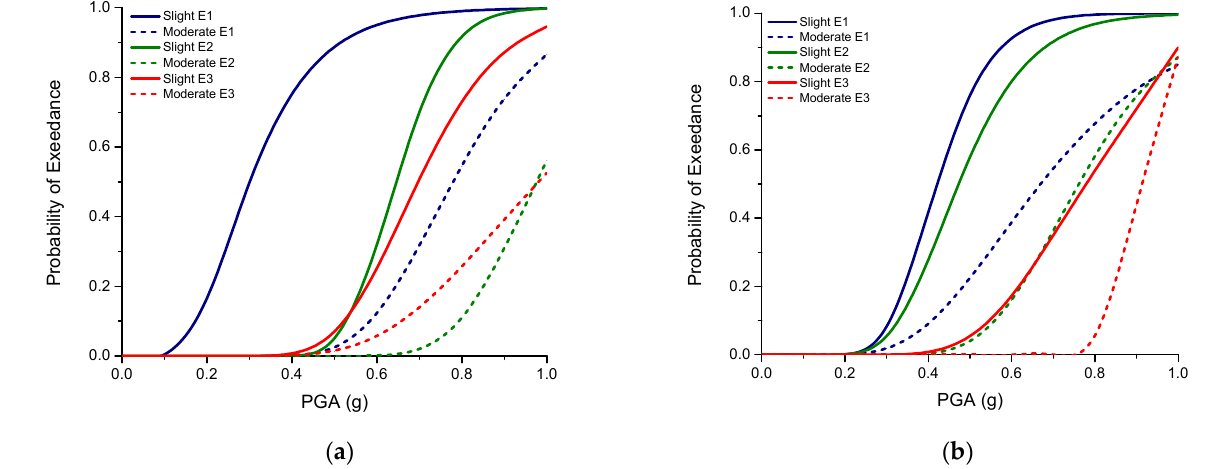
Figure 5. Fragility curves of the embankments due to H/B ratio ( a ) near-ground motions ( b ) far- ground motions.